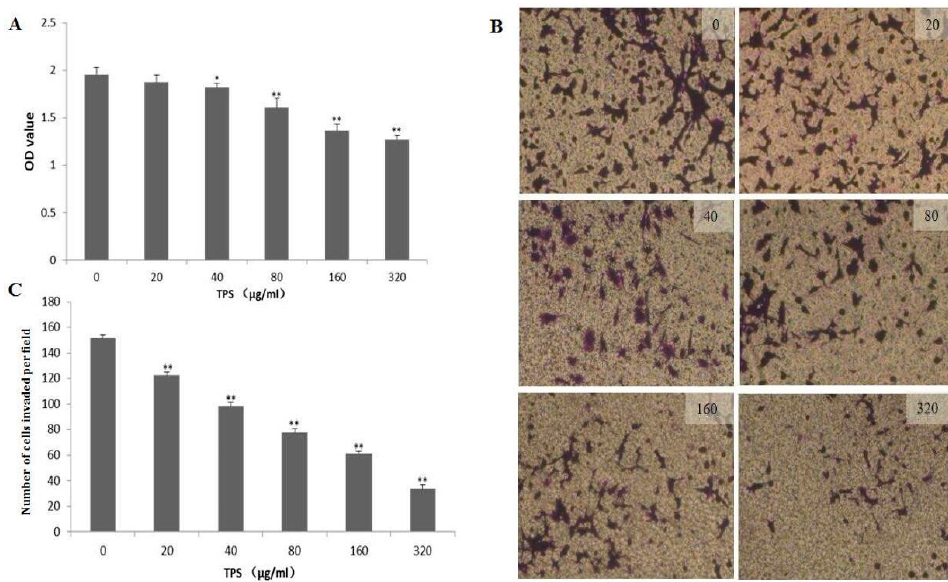
Figure 5. ( A ) Effect of TPS on the proliferation of CT26 cells. CT26 cells were seeded into 96-well culture plates and treated with TPS at different concentrations for 48 h. The proliferation of CT26 cells was evaluated using CCK8 assays. Bar graphs show mean ± SD of three independent experiments. * p < 0.05, ** p < 0.01 vs. control group. ( B ) TPS inhibited the invasion ability of CT26 cells. The CT26 cells were seeded into 24-well Matrigel-coated transwell chambers and incubated at 37 °C for 48 h with TPS at different concentrations. ( C ) Bar graphs show the results of Boyden chamber assays, TPS significantly inhibited the CT26 cells’ invasion in a dose-dependent manner. The results are expressed as mean ± SD of three independent experiments. * p < 0.05, ** p < 0.01 vs. control group.